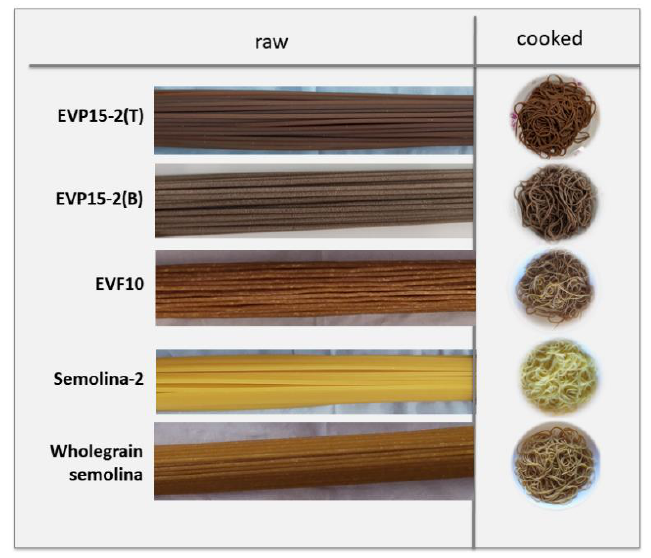
Figure 2. Pictures of dried (on left) and cooked (on right) spaghetti.